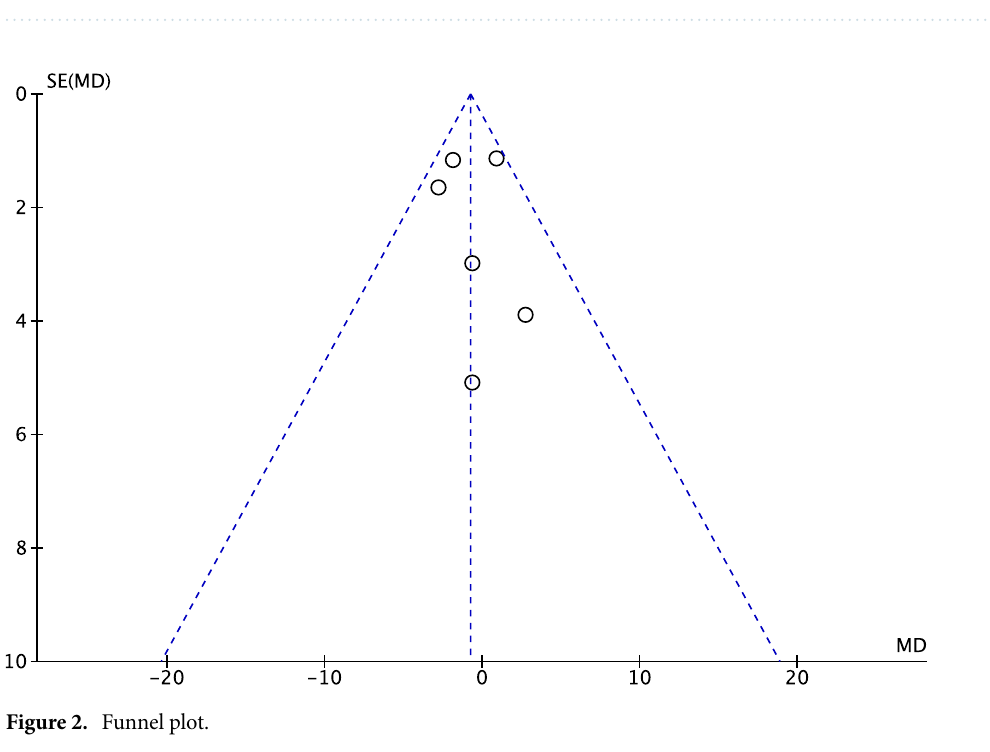
Figure 2. Funnel